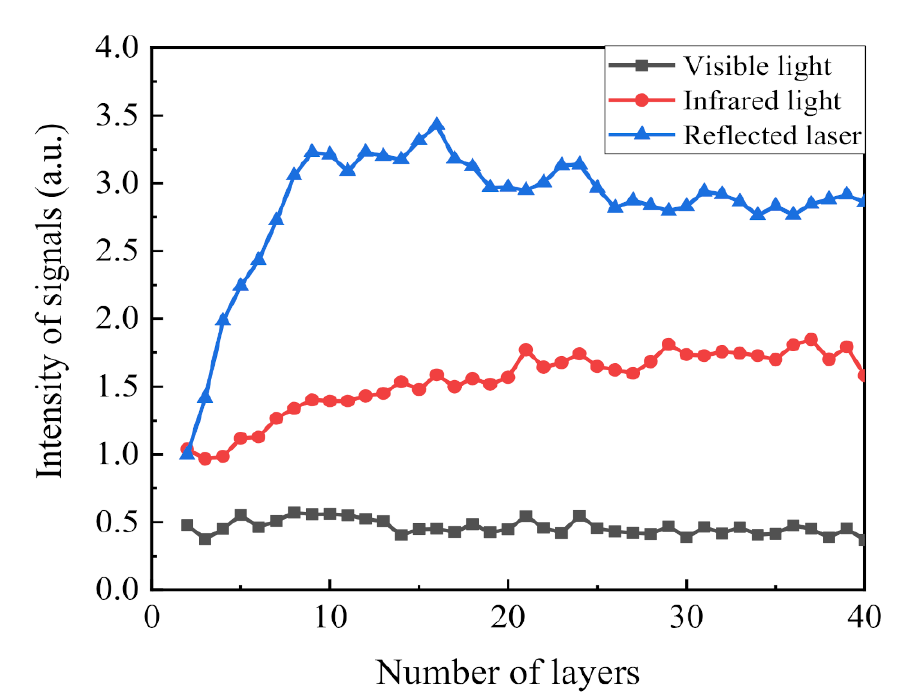
Figure 9. Variation of visible light, infrared light, and reflected lasers with layers during the LMD process of aluminum alloy thin-walled